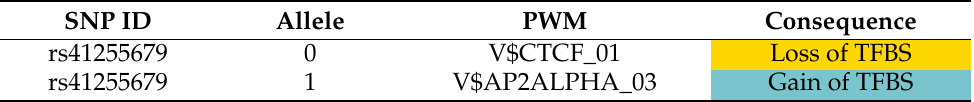
Table 4. Consequences of SNP rs41255679 (C/G), located upstream of the TSS of the bovine LGB gene. Allele 0 refers to a predicted TFBS in the reference sequence, while allele 1 stands for the alternate allele. A SNP causes a loss of TFBS if the considered TFBS (represented by a PWM) is only predicted for the reference allele. Consequently, a SNP causes a gain of TFBS if the TFBS is only predicted for the alternate allele.